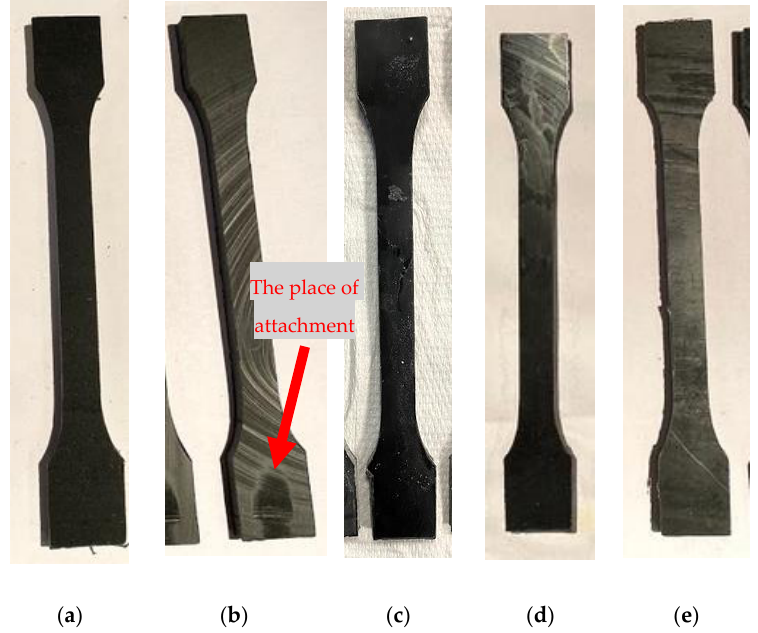
Figure 4. Representative samples with some visible effects on the surface compared to the unaged one. ( a ) reference (I), ( b ) weathering (II)—red arrow shows the place of attachment, which was covered from the sun radiation, ( c ) alkalis at 20 °C (V), ( d ) tap water (VIII), ( e ) frozen water (IX). Figure 5. Solid residue in immersion fluids ( a ) Alkalis at 20 °C—white crystals in the shape of petals, ( b ) Alkalis at 60 °C—white suspension of fine particles, ( c ) white/colorless fine crystals. For provided tensile tests mean values and standard derivations were calculated and compared via Tukey test for initial Young’s modulus— E 0 (Figure 6a), equivalent Young’s modulus— E ’ (Figure 6b), tensile strength (maximal stress)—σ M (Figure 6c), maximal strain—ε M (Figure 6d), maximal work (area under the curve in Figure 3c)— W M (Figure 6e). The Tukey test showed if there were statistically significant differences. Three significance levels were applied: p < 0.05; p < 0.01; p < 0.001, where the lower the p -value, the more significant difference between two means.